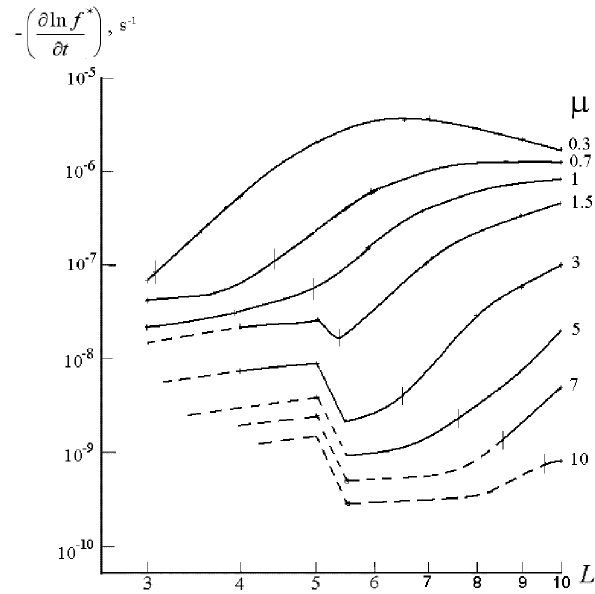
Figure 8. The radial dependence of the ionization losses of protons with µ from 0.3 to 10keVnT − 1 , calculated on the modern models of the plasmasphere and the